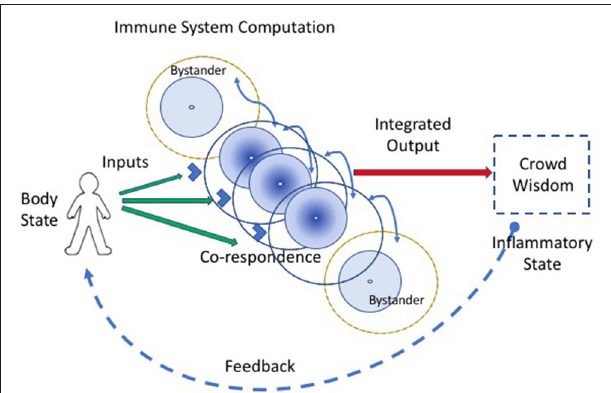
FIGURE 2 | Co-respondence between cells generates immune computation at the systemic scale. An integrated immune response results from the ability of individual immune cells to tune their inflammatory responses in the light of the responses they sense from adjacent cells (the curved blue lines connecting cells); this co-respondence is mediated by innate receptors. Bystander cells, which may lack direct input signals from the body, are enlisted into the response by co-respondence with adjacent immune